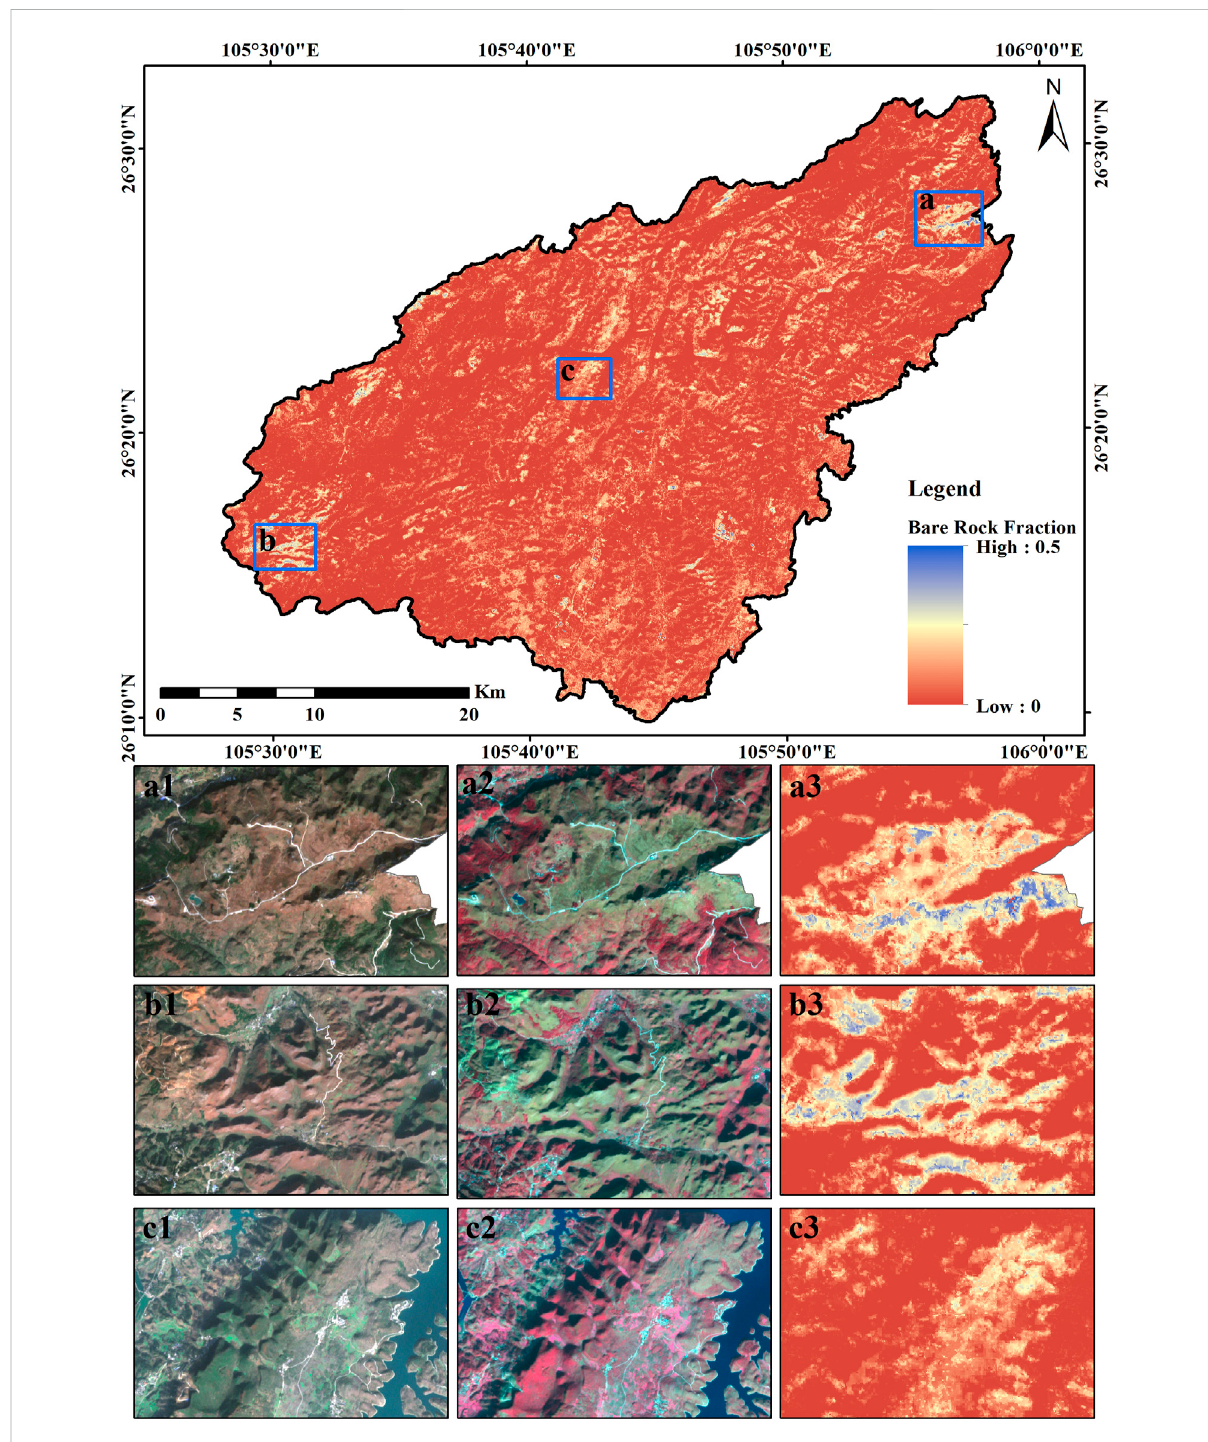
FIGURE 10 Spatial distribution map of f BR based on Sentinel-2. (*1 true-color, *2 stand false-color, *3 f BR